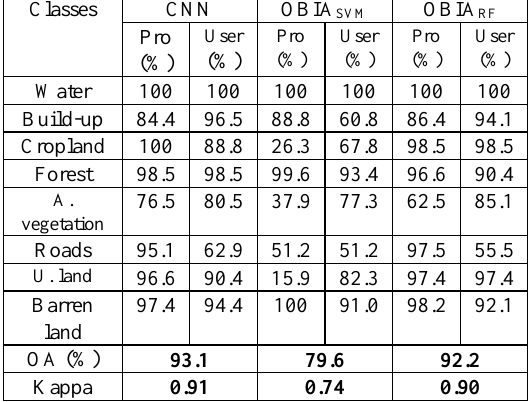
Table 1: Results of Overall Accuracy (OA) and Kappa index of CNN-OBIA, OBIA SVM and OBIA RF